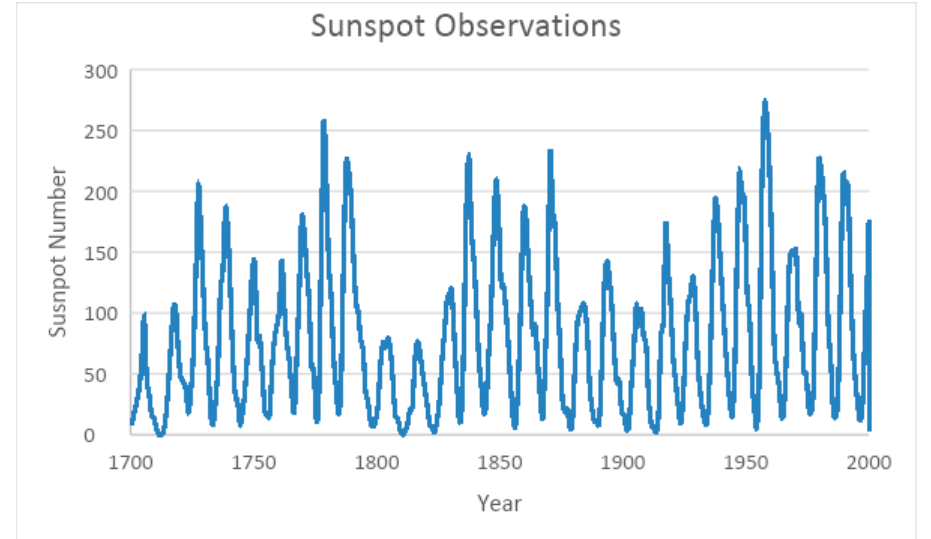
Figure 1. Number of sunspots over the years.